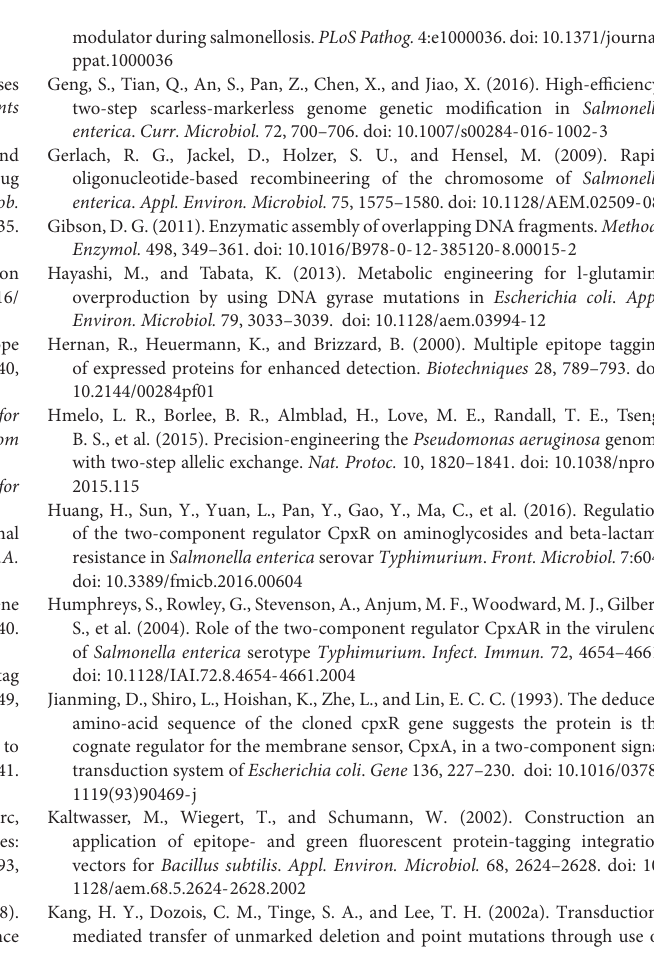
FIGURE S2 | Functional identification of scaBKan cassette inserting some specific locus. Kanamycin and sucrose sensibility of intermedia strains JS CpxR:sacBKan , JS CpxA:sacBKan, and JS acrB:sacBKan are identified on LB plate with 50 µ g/ml kanamycin and 8% sucrose. FIGURE S3 | PCR for sacBKan cassette integration. Intermediate strain JS CpxR:sacBKan : CpxR-F/R, 4.40 kb; CpxR-F/sacBKan-k2: 3.10kb; FIGURE S4 | Preparation of various recombinogenic DNA of CpxR . In PCR-1, the corresponding downstream and upstream regions of various DNA modification fragments CpxR D 51 A , CpxR M 199 A , CpxR SD , CpxR N − 3 × FLAG , and CpxR D 51 A / M 199 A (require additional midstream), were amplified by PCR using the genomic DNA of WT strain JS. 3 × FLAG, tagging the N-terminal of CpxR, was amplified by PCR using a pairs of complementary oligonucleotides. UP, upstream region of the target gene to be modified. DW, downstream region of the target gene to be modified. MD, midstream region of the target gene to be modified. In seamless assembly, successful assembly of corresponding PCR products were confirmed by PCR with primers CpxR-UF/DR. In PCR-2, various recombinogenic DNA